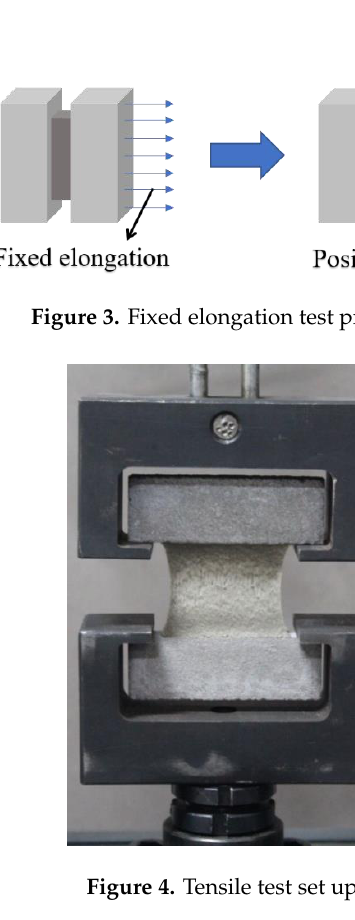
Figure 2. Fixed elongation test set up.